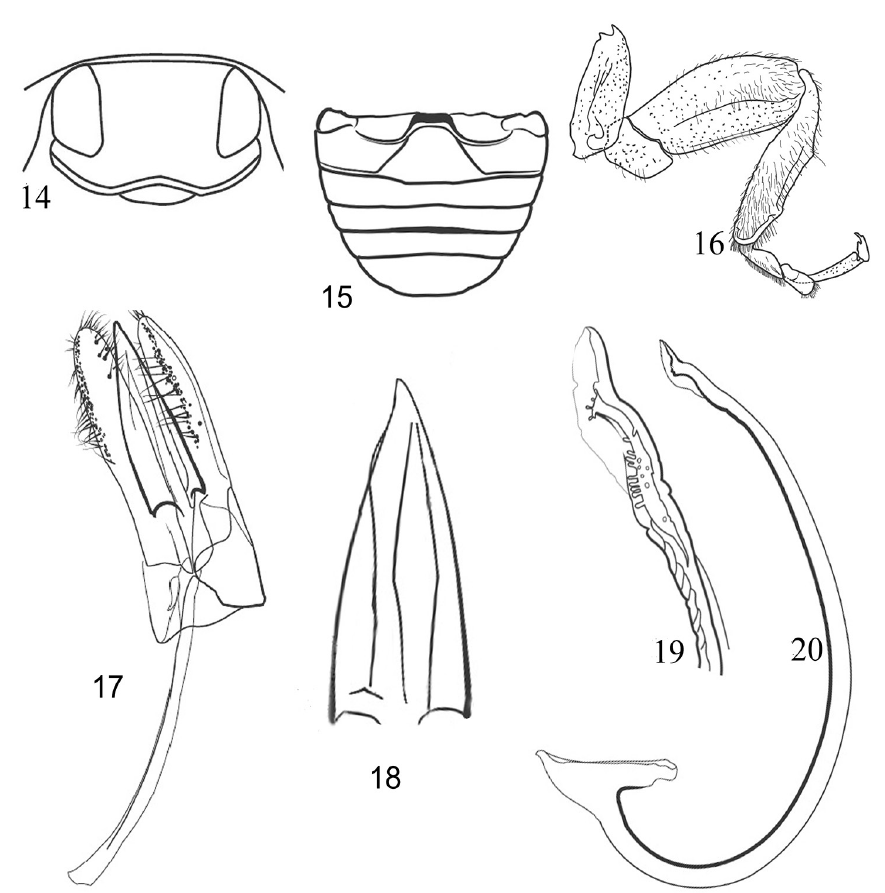
Exochomus quadriguttatus Fleischer, 1900 Figs 6, 29–31 Exochomus quadriguttatus Fleischer, 1900: